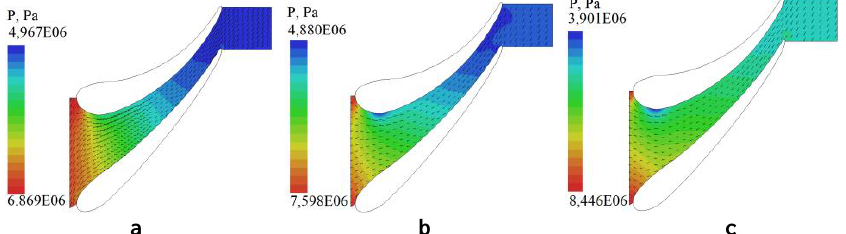
Figure 6. Contours of static pressure and velocity vectors. Figure 7. Contours of static pressure and velocity vectors. Mid-span blade-to-blade Mid-blade-to-blade meridional section of the rotor: Figure 6: Contours of static pressure and velocity vectors. Mid-blade-to-blade meridional section of the rotor: a - the minimum flow; b - the section of the rotor: a – the minimum flow; b - the nominal mode; c - the maximum flow nominal mode; c - the maximum flow a – the minimum flow; b - the nominal mode; c - the maximum flow